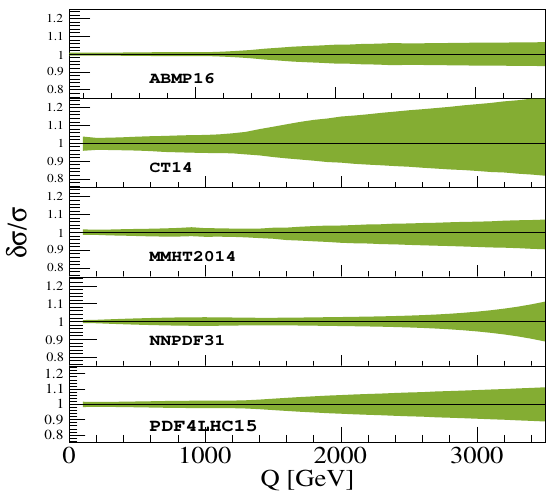
Figure 7 . Intrinsic PDF uncertainties in di-lepton invariant mass distribution have been estimated at NNLO+NNLL level taking (cid:22) r = (cid:22) f = Q . Here (cid:27) is obtained from the central set n = 0 provided by the respective PDF